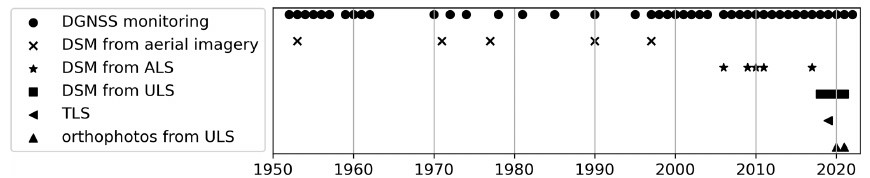
Figure 2. Overview of datasets used in this study: DSMs, orthophotos, and TLS data as detailed in Table 2. DGNSS monitoring refers to in situ geodetic monitoring of block